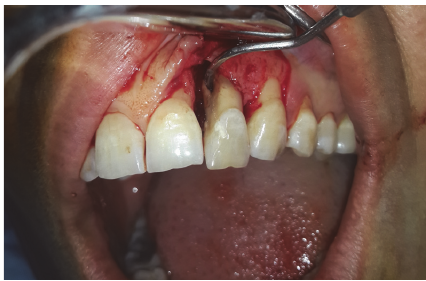
Figure 4: A full thickness mucoperiosteal flap was raised on labial and palatal aspects of tooth #10 to access the radicular groove.